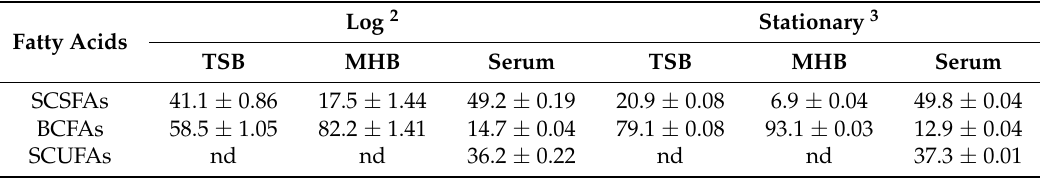
Table 4. Fatty acid composition (%) 1 of a naturally carotenoid-deficient strain MSHR1132 ( S. argenteus ) grown in various media.